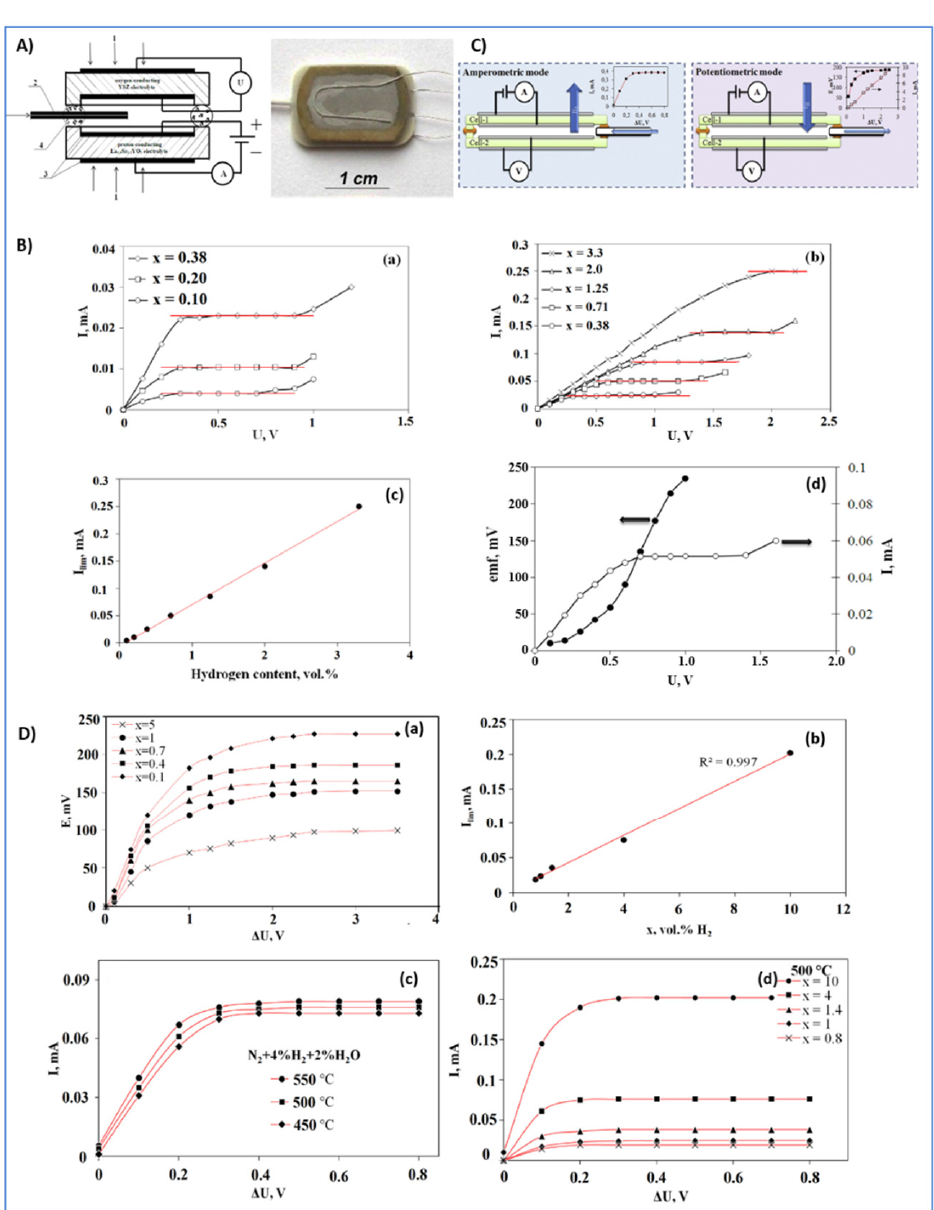
Figure 3. ( A ) Schematic representation of the hydrogen amperometric sensor (left): (1) the ambient gas, (2) the ceramic capillary, (3) the Pt electrodes, and (4) the glass sealants; (right) the experimental cell. Reproduced with permission from [18]. ( B ) (a,b) Dependence of current on the applied voltage for x vol.% H 2 in N 2 + H 2 mixture at 550 ◦ C, (c) dependence of limiting current to hydrogen content, and (d) I and ∆ V oc plotted against U for the 0.7 vol.% H 2 + N 2 mixture at 550 ◦ C. Reproduced with permission from [18]. ( C ) Combined potentiometric (a) amperometric (b) hydrogen sensor, (1) BZCY proton conductor, (2) chamber inside the sensor, (3) capillary barrier, (4) Pt electrodes, and (5) glass sealant. Reproduced with permission from [52]. ( D ) (a) EMF-V curves for different hydrogen content in x%H 2 + N 2 + 2%H 2 O gas mixtures at 500 ◦ C; (b) the limiting current as a function of hydrogen content in N 2 + H 2 mixture at 500 ◦ C; (c) I-V curves for different temperatures of operation and (d) for different H 2 concentrations at 500 ◦ C. Reproduced with permission from